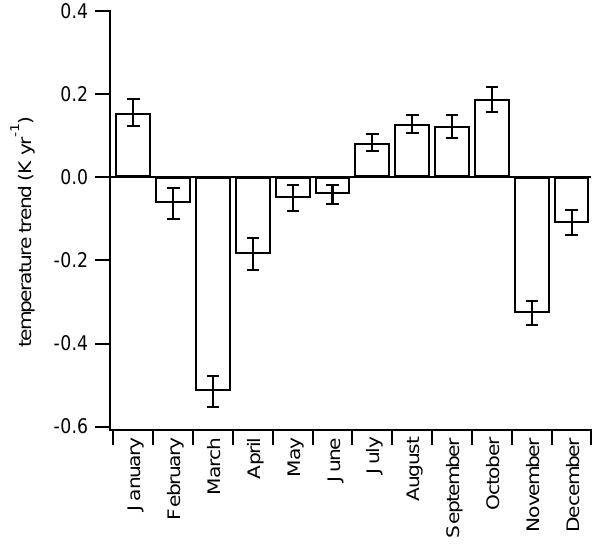
Fig. 5. 1995–2007 trends in local temperature at Alert calculated for each month by Sen’s estimator of